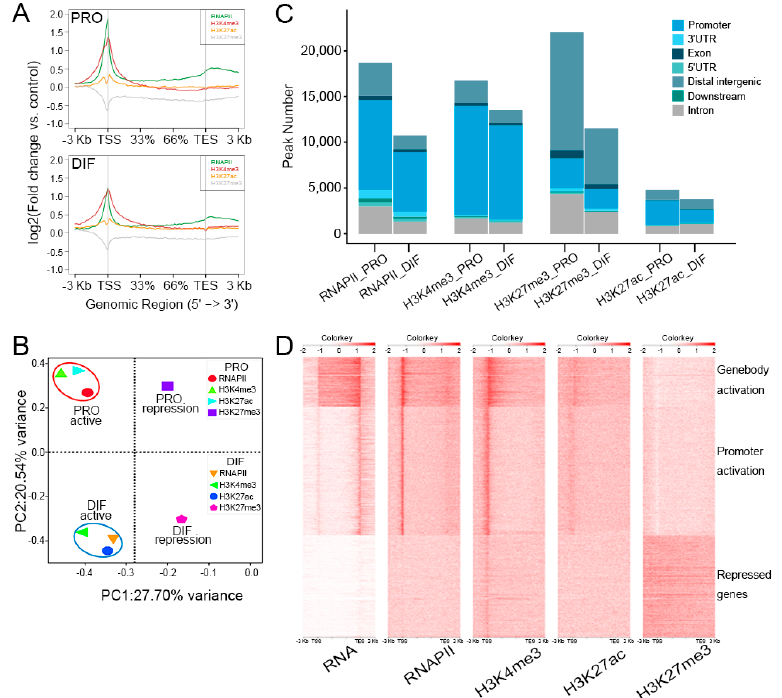
The insight of epigenomic alteration during PSCs differentiation. ( A ) Chromatin Immunoprecipitation Sequencing (ChIP-Seq) enrichment were plotted at − 3 kb of the transcription start site (TSS) and +3 kb of the TES to show the presumable binding sites of three epigenetic marks and RNA polymerase II (RNAPII) of PRO (upper panel) and DIF (bottom panel) cells. The y-axis was the average log2 fold change compared with control. ( B ) Data from three histone modifications and RNAPII between PRO and DIF cells were clustered into four parts according to cell phases and histone functions, which showed the distinction of histone modifications during cell differentiation. The first and second principal components were depicted as x-axis and y-axis. ( C ) The peak numbers of three epigenetic marks and RNAPII were described, and chromatin was illustrated into seven parts to show the distribution of modification peaks. ( D ) ChIP-Seq enrichments were plotted using a heatmap, which demonstrated the depositing of three histone modifications and RNAPII, and the correlation associated with gene expression profiles of myotubes. Maps were generated from 3 kb upstream of the TSSs to 3 kb downstream of the TESs. Three clusters were labeled according to gene expression and histone modification levels.